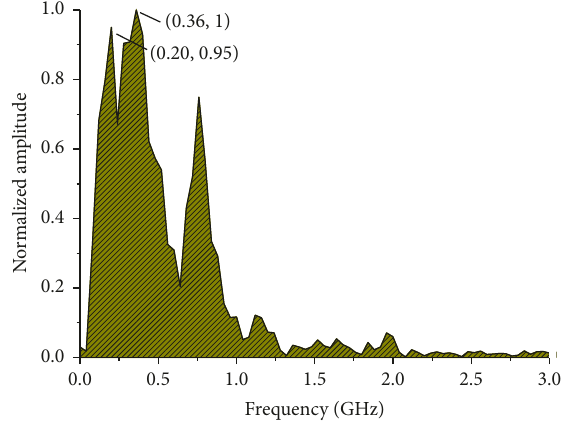
Figure 3: The frequency-domain waveform of UWB EMP.